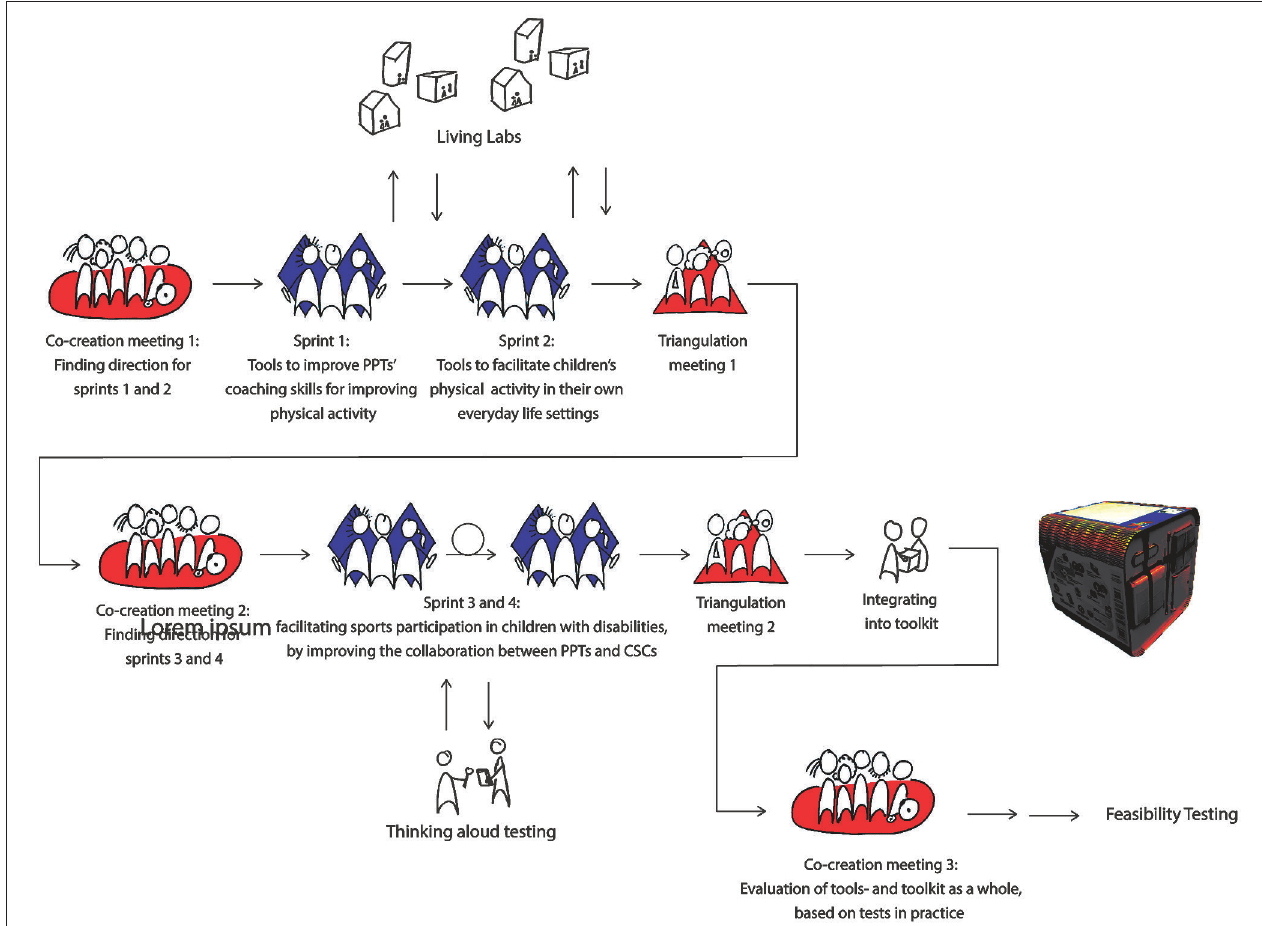
FIGURE 1 | A visual representation of the co-design process containing three co-creation sessions, four one-week design sprints, living lab testing, and two triangulation sessions.